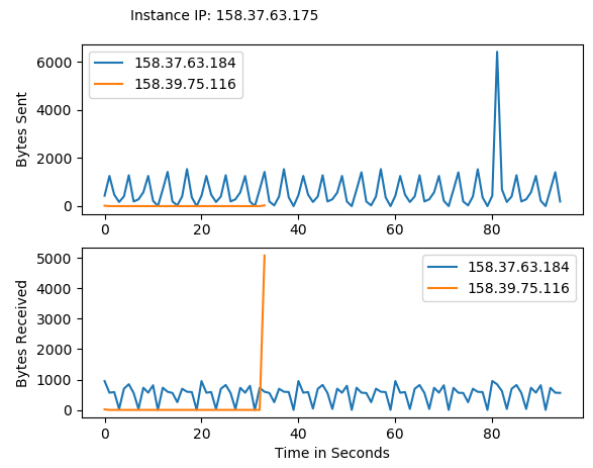
Figure 14. Transaction Traffic for VM 3.